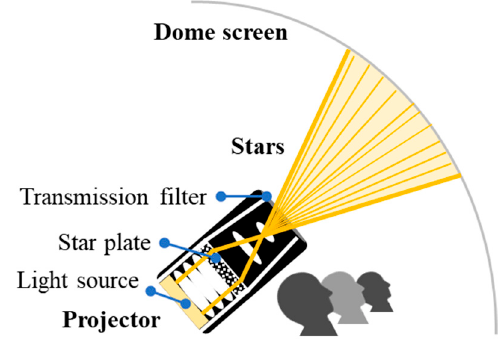
Figure 1. Mechanism of optical projection.